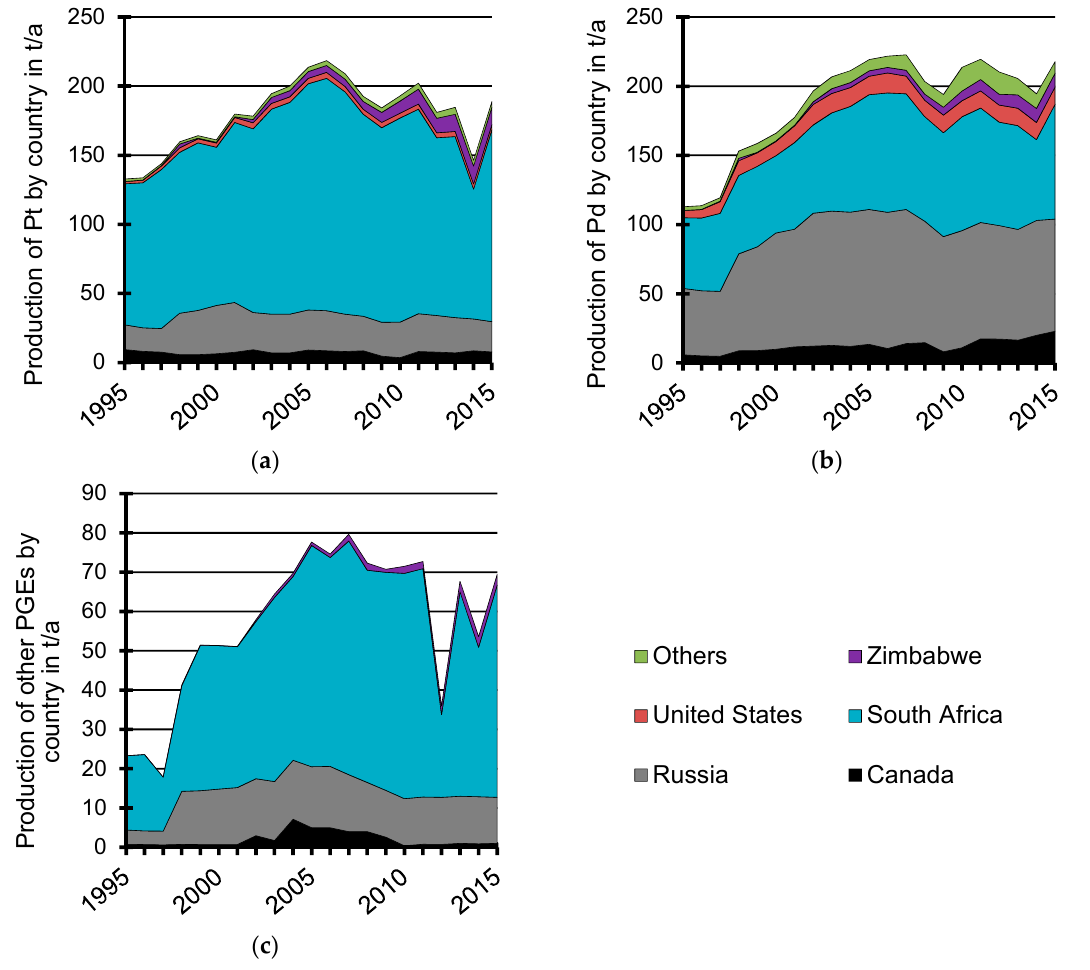
Figure 2. Primary production of Pt ( a ), Pd ( b ) and other PGEs ( c ) by selected countries [11].